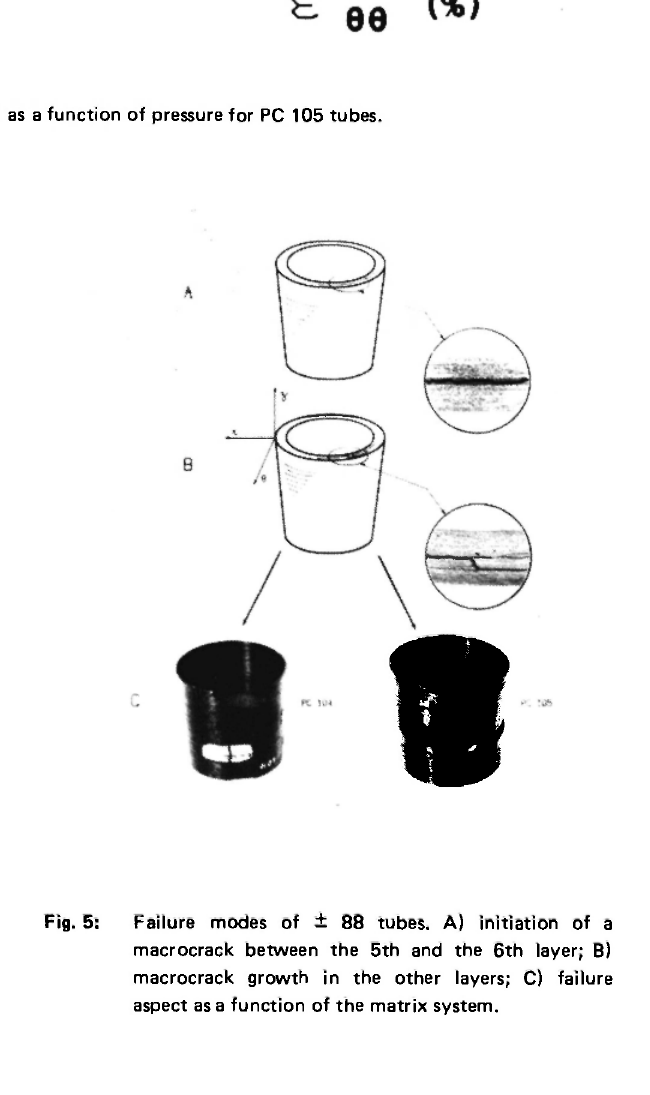
Fig. 4: Axial and hoop strain curves as a function of pressure for PC 105 tubes.